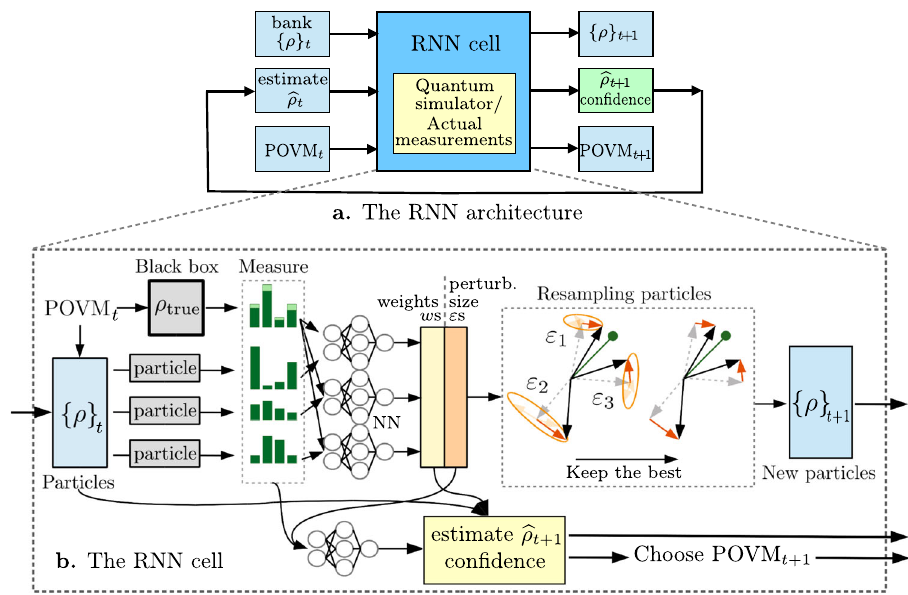
Fig. 1 Our custom-built recurrent neural network (RNN) architecture. After every round of measurement, generating a new set of data, the RNN cell takes a previously generated bank of weighted candidate states —“ particles ”— and the best guess for the (unknown) true state as inputs and outputs a re fi ned bank of particles together with a new estimate of the true state and an associated con fi dence value. In addition, the re fi ned bank is used to select the next measurement to be performed. This process is iterated, gradually converging to the correct density matrix. During training, there are two stages of analysis for each measurement round: the fi rst stage updates the weights in the bank; the second stage updates the